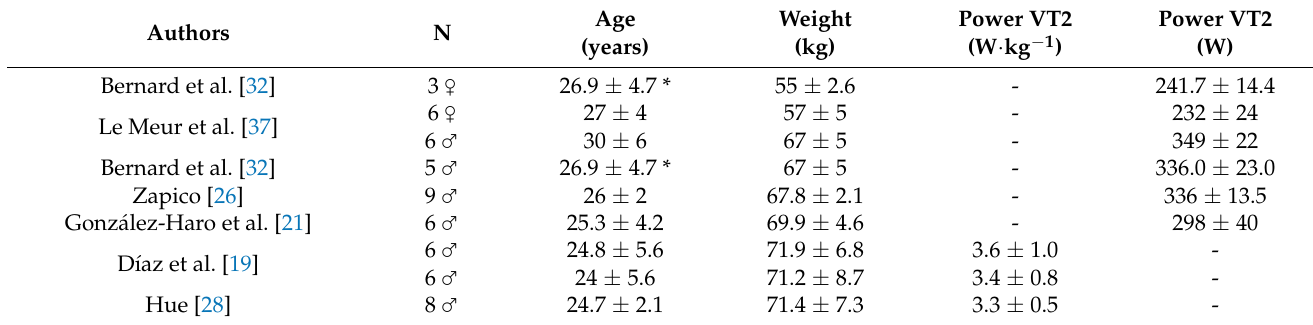
Table 8. Mean ± SD power values at VT2 of elite